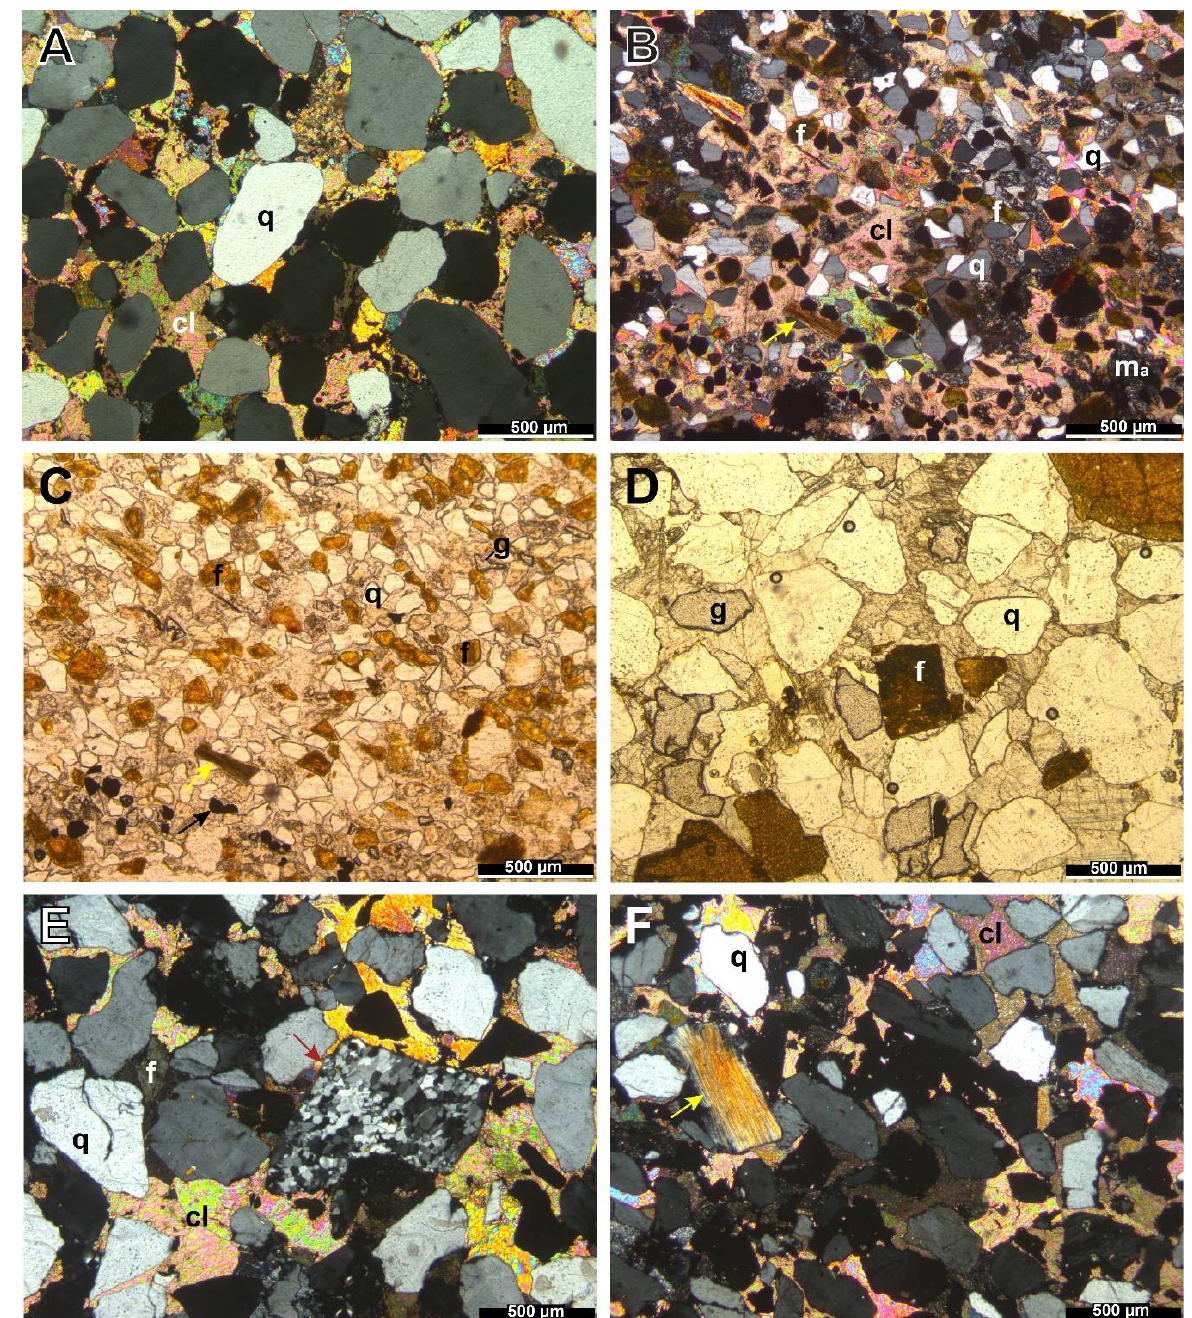
Figure 3. Photomicrographs showing ( A ) sub-angular to sub-rounded, medium-grains of quartz grains (q) and orthoclase feldspar, floating in poikilotopic calcite cement (cl) as seen under cross- polarized light; ( B ) fine biotite grains (yellow arrow), stained feldspar grains (f) and mud aggregates (ma) as seen under cross-polarized light; ( C ) fine grains of stained orthoclase feldspar (f), black opaque minerals (black arrow) and garnets (g) as seen under plane-polarized light, within the Yerrapalli sandstone sample. Photomicrographs showing ( D ) point contact between the medium- to coarse-sand-size, sub-angular framework grains, stained orthoclase feldspar (f) and garnet (g) in otherwise floating grains in poikilotopic calcite cement as seen under plane-polarized light; ( E ) lithic fragment (red arrow) and ( F ) biotite grains (yellow arrow) as seen under cross-polarized light, within the Bhimaram sandstone sample.